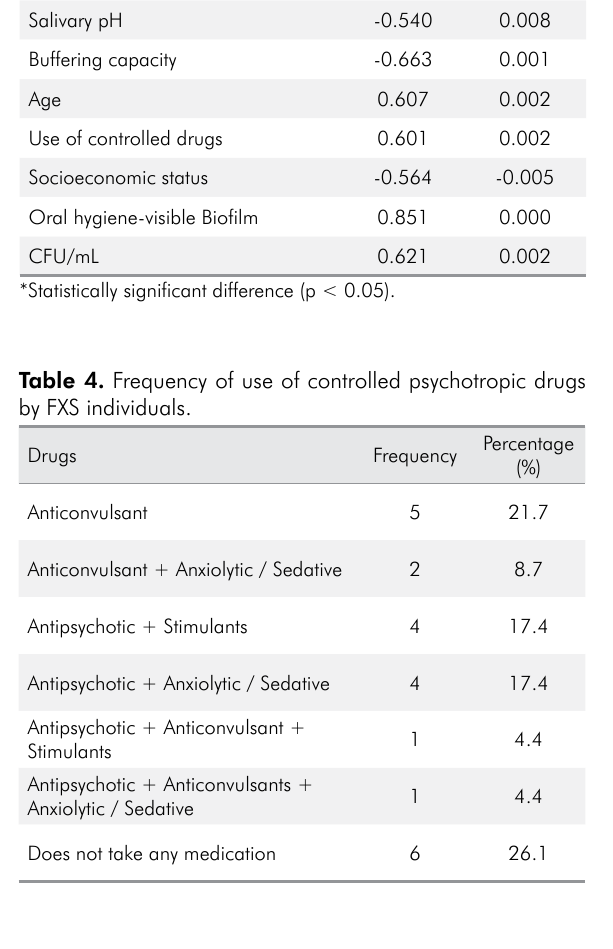
Table 3. Correlation (r) between experience of dental caries and salivary pH, flow, buffering capacity, age, medications, socioeconomic level, oral hygiene and CFU/mL.